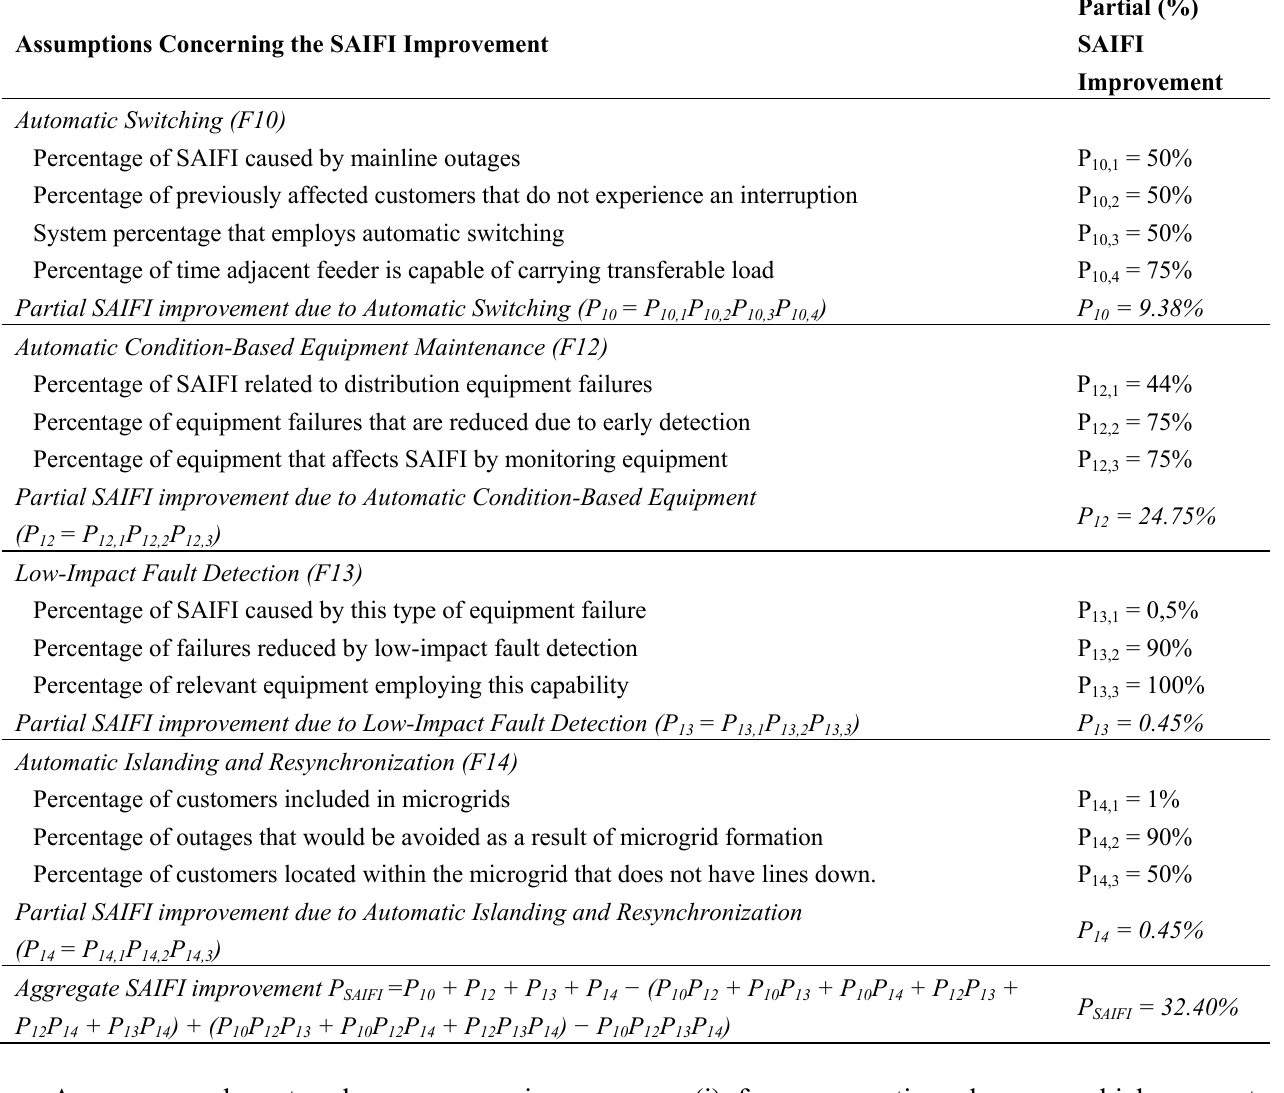
Table 2. SAIFI assumptions and